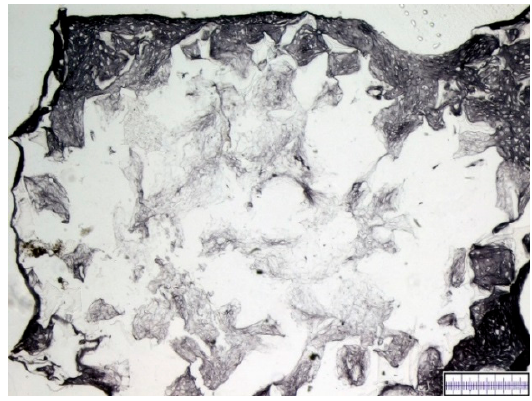
Figure 7. Representative slide of a hyaluronic acid gelatin composite scaffold after 21 days of in vitro chondrogenesis. Collagen type I immunohistochemistry. Collagen type I-rich areas appear black. Magnification bar = 500 μ m. Materials 2016 , 9 , 276